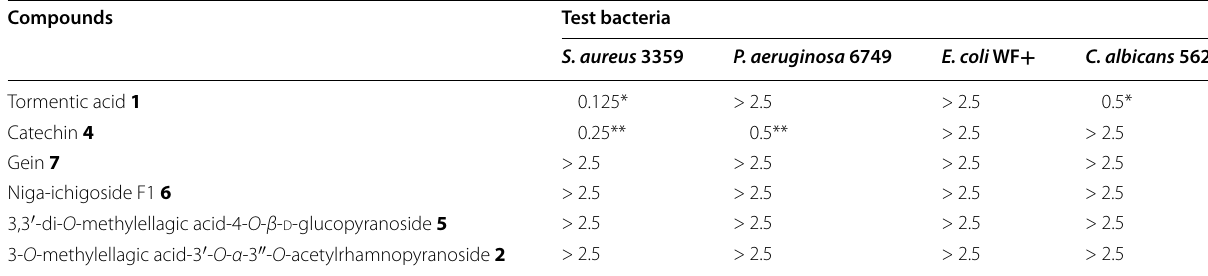
2.5 mg/ml is the highest test concentration of